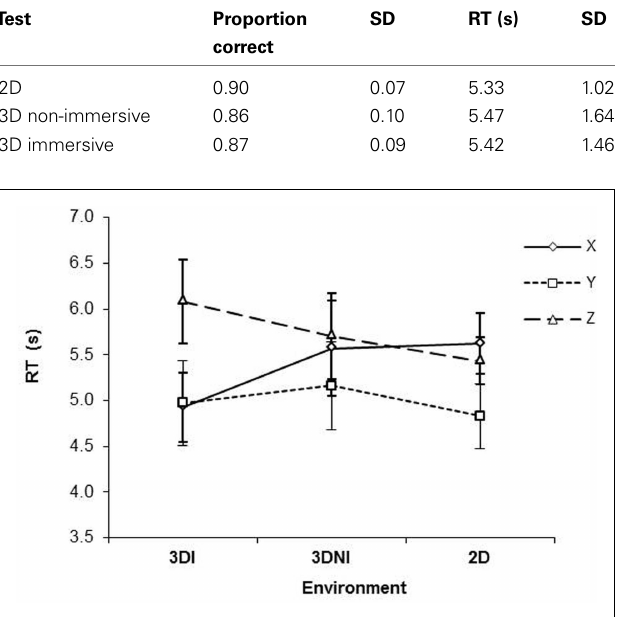
FIGURE 4 | Response time as a function of angle and axis of rotation in (A) 2DNI, (B) 3DNI, and (C) 3DI